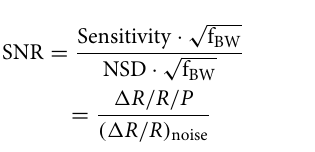
Figure 4. ( A ) Conceptual design of the experimental setup to evaluate the performance of the cantilever ( B ) Photographs of the experimental setup. ( C ) Measurement results of the sensitivity and noise spectrum of the cantilever output. ( D ) The resolution and SNR derived from the results in ( C ). ( E ) Raw data of the cantilever and reference microphone output. ( F ) Relationship between the resistance change of the cantilever and the applied sound